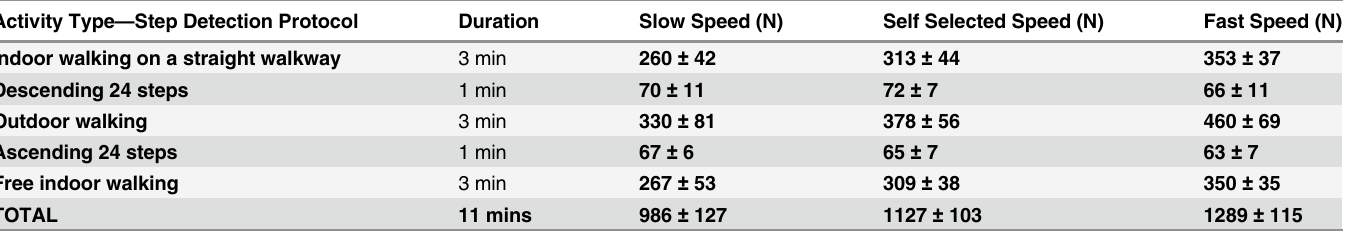
Table 3. Summary of the activities performed during the step detection protocol, their duration and the step count (as obtained by the OPAL sensors) for each walking speed. Activity Type — Step Detection Protocol